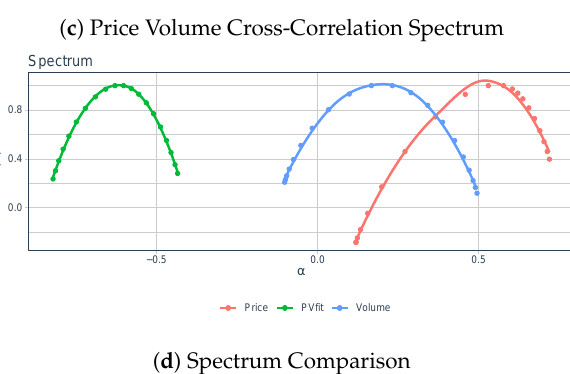
Figure 6. Segment 2 price, volume, and price-volume cross-correlation